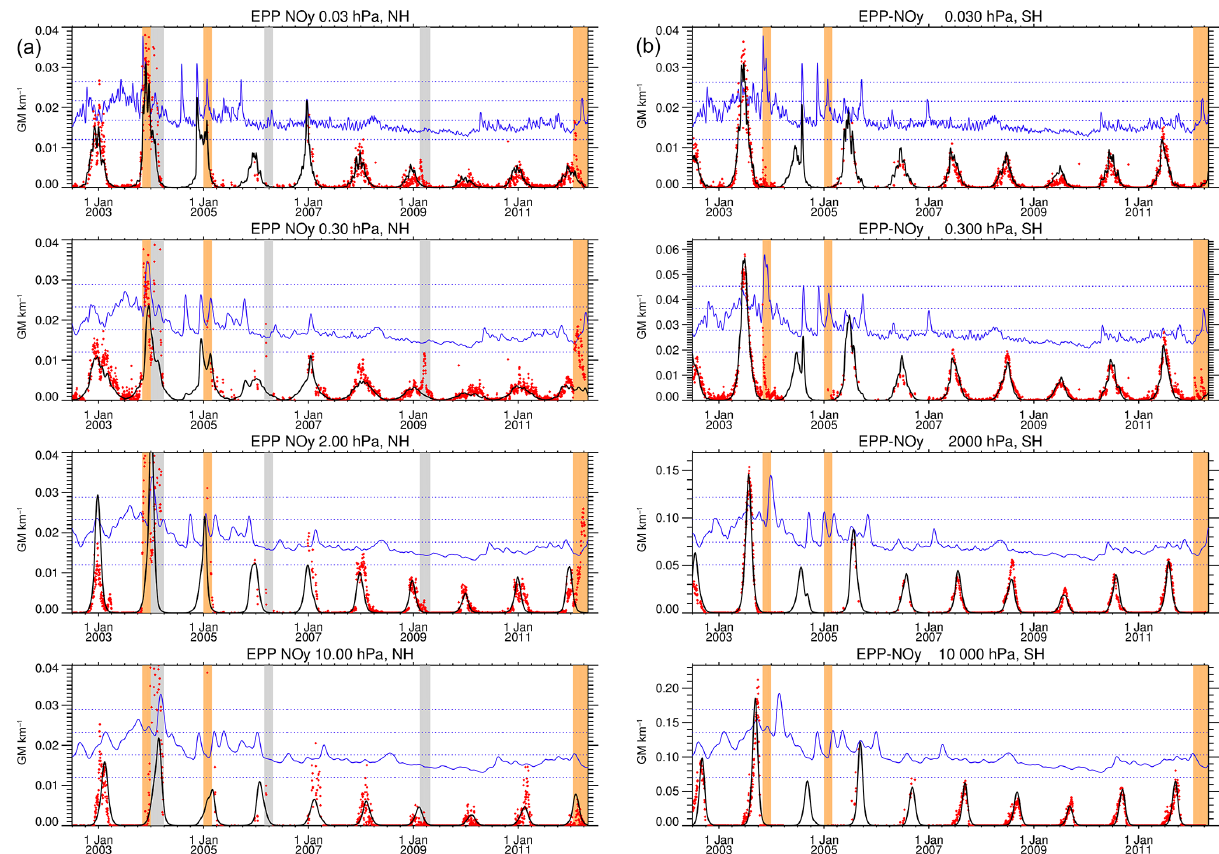
Figure 3. (a) Observed (red diamonds) and fitted (solid black) temporal evolution of hemispheric EPP-NO y amounts during 2002–2012 at the pressure levels 0.03, 0.3, 2, and 10hPa (top to bottom) in the NH. A p (z,t) of the empirical model for quiescent dynamical conditions is shown with blue lines (dotted blue lines indicate A p levels with a spacing of 5 A p units). Shaded areas have been excluded from the fit due to perturbed dynamics (i.e., SSW and ES events, grey) and large SPE events (orange). Note that the y axis range does not cover the very high NO y amounts encountered in the NH 2003/04 winter. (b) As for panel (a) but for the SH. Note the variable y axis